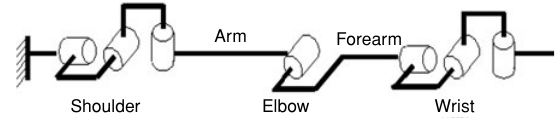
Figure 11 Seven degrees of freedom arm model. (Shoulder: 3 DoF, Elbow: 1 DoF, Wrist: 3 DoF).